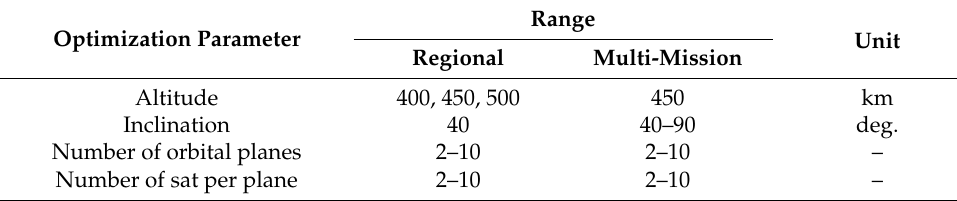
Table 2. Optimization parameters with their boundary value for two simulation cases.